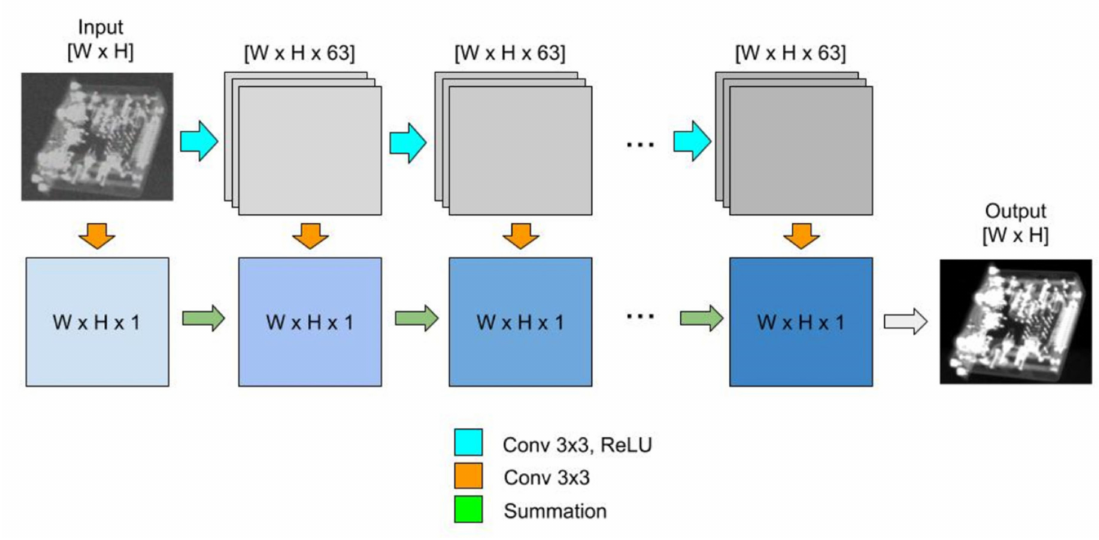
Figure 10. CNN architecture according to